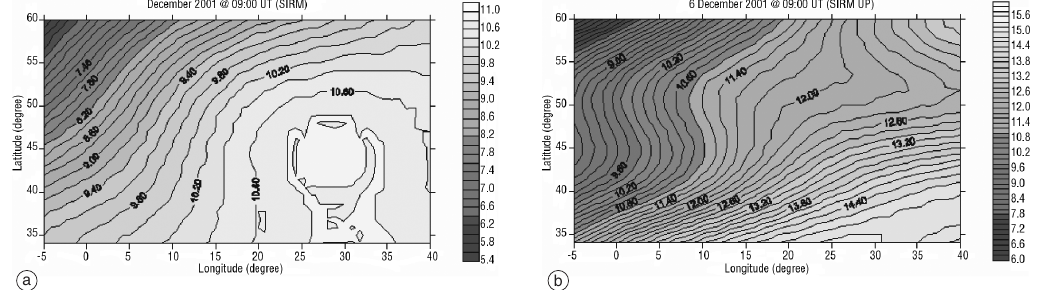
Fig. 3.7a,b. The European foF 2 maps for 6 December 1991, 09:00 UT, produced by the SIRM and SIRMUP models: a) SIRM output; b) SIRMUP